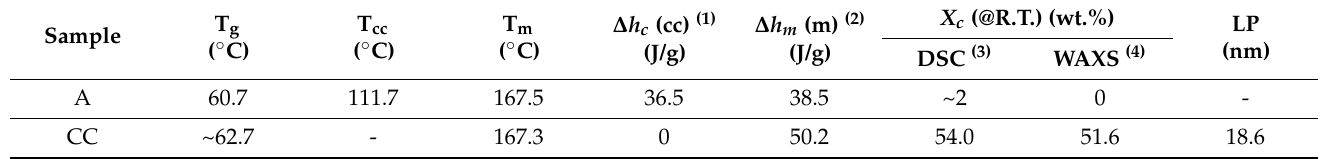
(1) The heat of fusion determined from the cold crystallization peak; (2) The heat of fusion determined from the melting peak; (3) Crystallinity of the sample estimated for the initial state of the sample, prior to heating in DSC, calculated from the difference of enthalpies related to melting and cold crystallization; (4) Crystallinity of the initial samples calculated from X-ray diffraction data, X c = Σ I cryst /( Σ I cryst + Σ I amorph